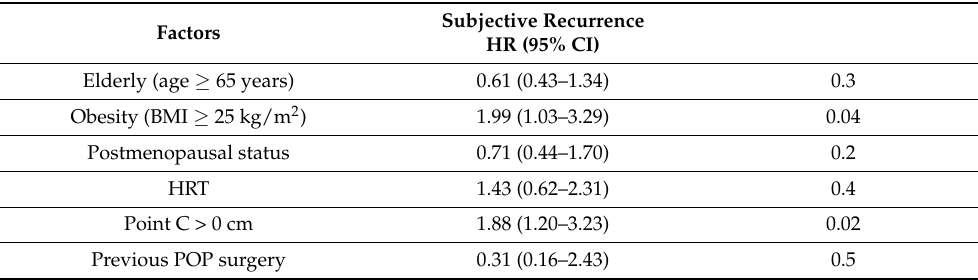
Table 6. Univariate analysis of potential risk factors related to POP